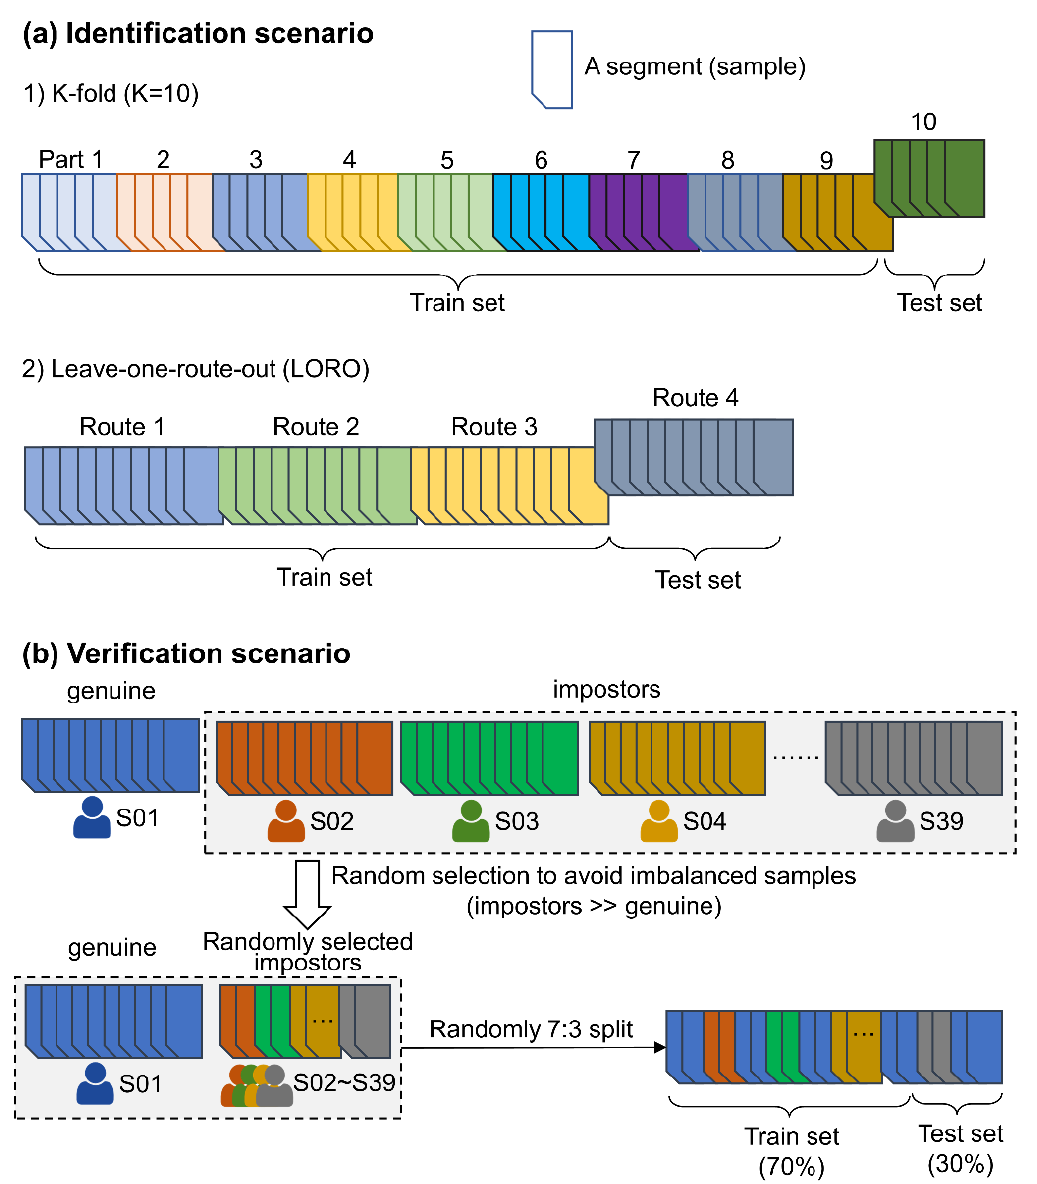
Figure 6. Classification and cross-validation of the ( a ) identification and ( b ) verification scenarios. Each segment was associated with a person’s identity and was considered an independent sample in the classification.